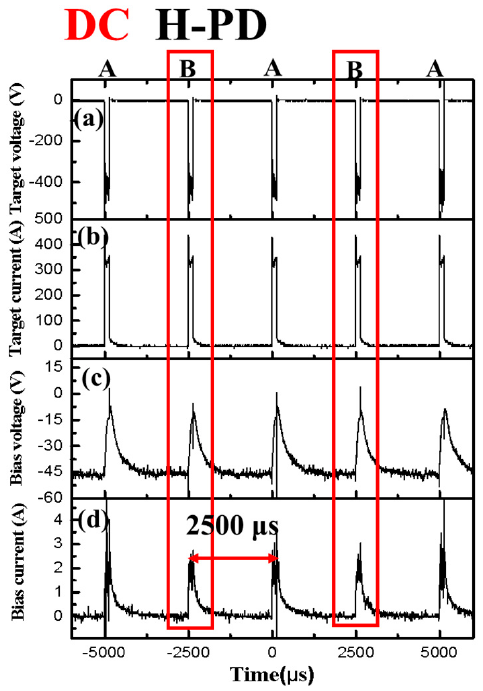
Figure 3. ( a ) V t , ( b ) I t , ( c ) V b and ( d ) I b waveforms when PD mode was specified. Table 3. I b and V b of TiN coatings obtained under various HiPIMS operating modes and bias power settings. (×: without specifying target, A or B; ○ : PD mode assigned for targets A and B).